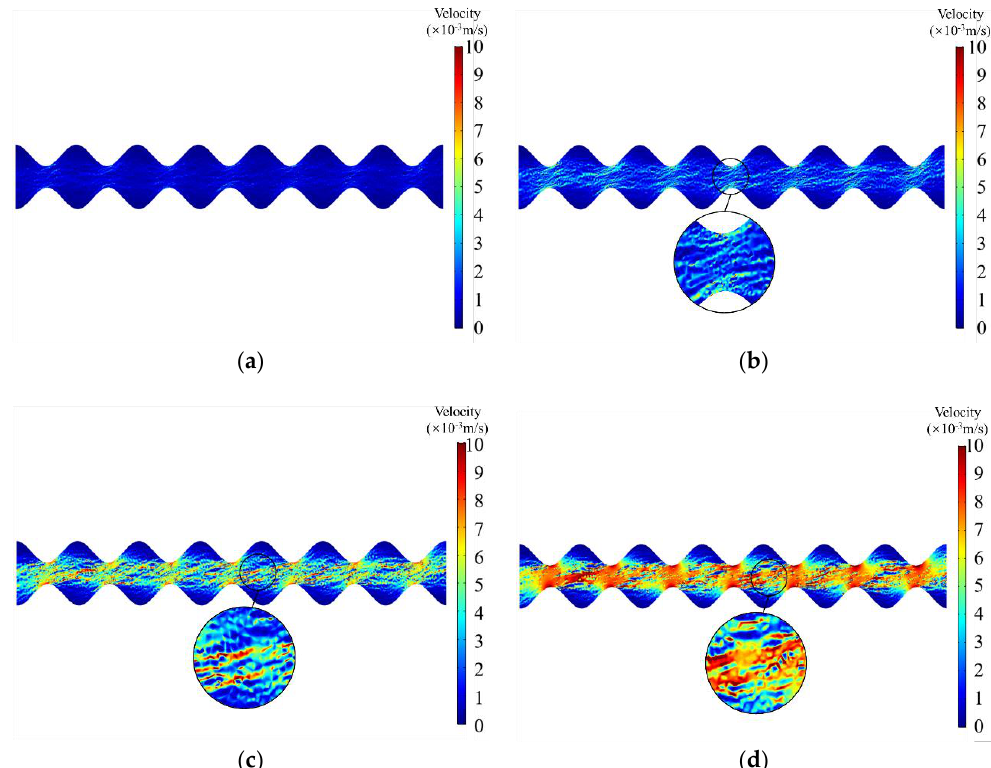
(cid:12) (cid:12) → (cid:12) (cid:12) ff erent times: ( a ) 20 s; ( b ) 40 s; ( c ) 60 s; ( d ) 80 s. (cid:12) (cid:12) q (cid:12) (cid:12) contours at di